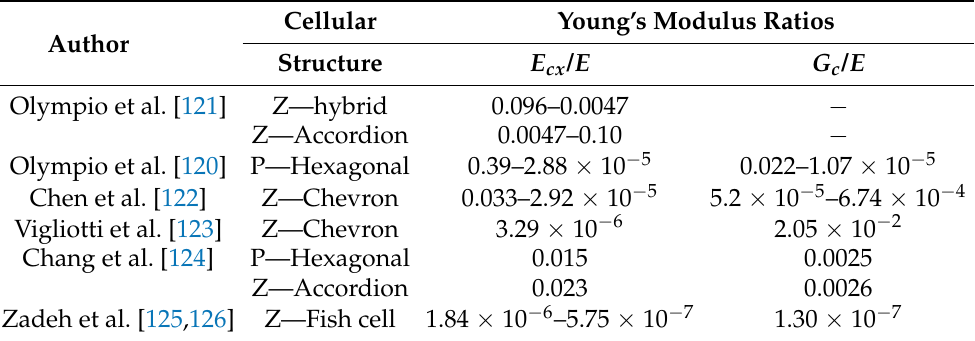
Table 2. Stiffness reduction via Cellular Materials: Airfoil-skin morphing. Principal works found in literature by author and cellular structure used (P: positive Poisson, Z: zero-Poisson, A: auxetic). Main direction Young’s modulus ratio E cx / E , and shear stiffness ratio G c / E . “ − ” indicates that there is no sufficient information reported to obtain that